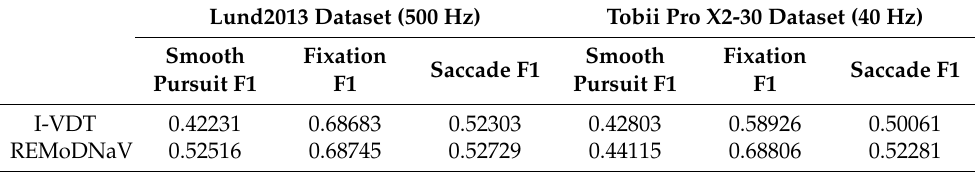
Table 1. F1 scores are compared for the eye movement event identification between the Lund2013 dataset [15] with the 500-Hz sampling rate and the data collected in this work through Tobii Pro X2-30 with the 40-Hz sampling